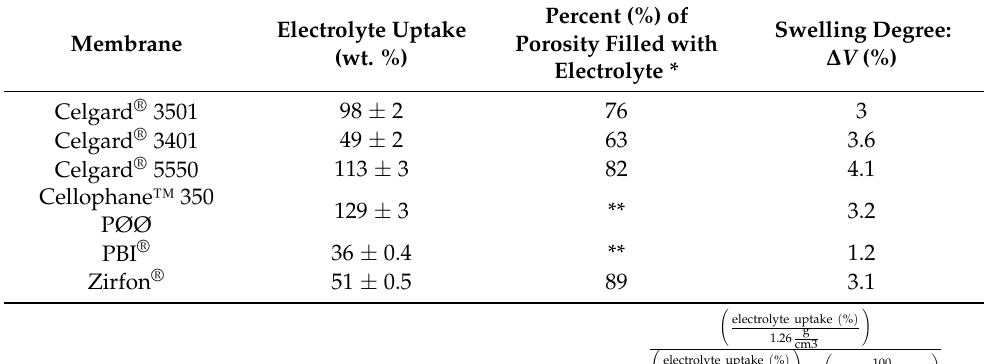
Table 2. Characterization of commercial membranes: electrolyte, swelling degree and conductivity. Percent (%) of Swelling Degree: Electrolyte Uptake Porosity Filled with Membrane ∆ V (%) (wt. %) Electrolyte * Celgard ® 3501 98 ± 2 76 3 Celgard ® 3401 49 ±